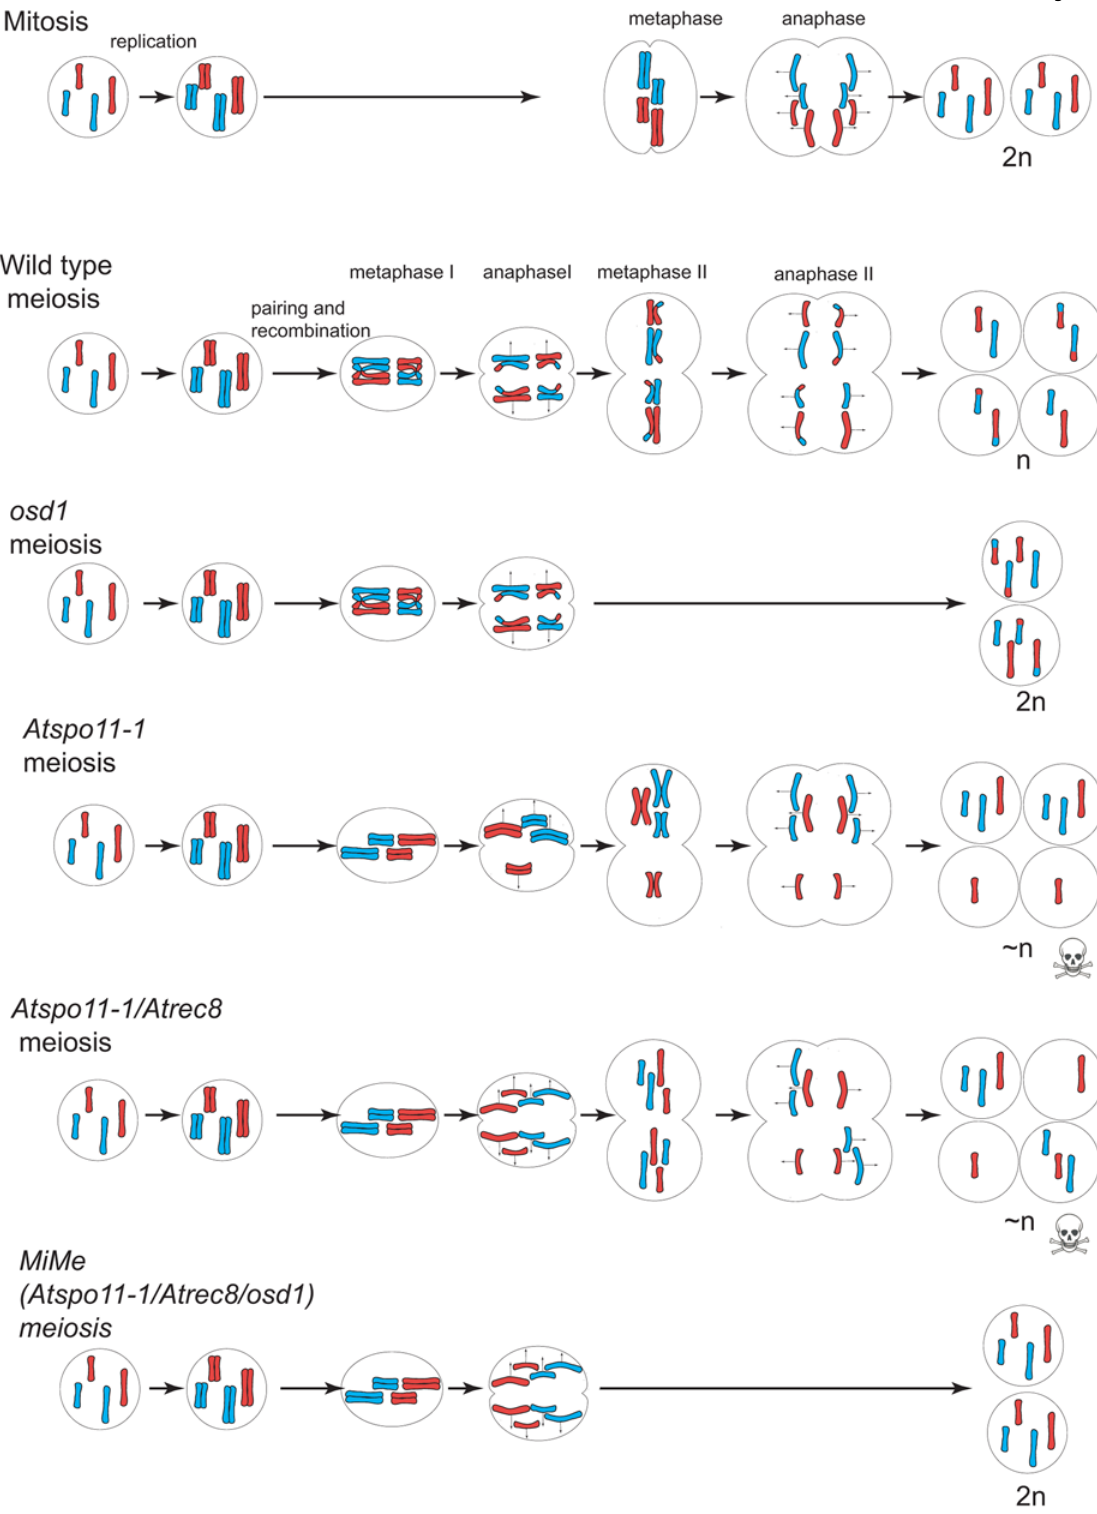
Figure 1. Schematic summary of the main results. During mitosis in diploid cells, chromosomes replicate and sister chromatids segregate to generate daughter cells that are diploid and genetically identical to the initial cell. During meiosis, two rounds of chromosome segregation follow a single round of replication. At division one, homologous chromosomes recombine and are separated. Meiosis II is more similar to mitosis, resulting in equal distribution of sister chromatids. The obtained spores are thus haploid and carry recombined genetic information. In the osd1 mutant (this study), meiosis II is skipped giving rise to diploid spores and gametes with recombined genetic information. The double Atspo11-1/Atrec8 mutant undergoes a mitotic-like division instead of a normal first meiotic division, followed by an unbalanced second division leading to unbalanced spores and sterility [9]. In the triple osd1/Atspo11-1/Atrec8 mutant ( MiMe , this study), the presence of the Atspo11-1 and Atrec8 mutations leads to a mitotic- like first meiotic division, and the presence of the osd1 mutation prevents the second meiotic division from occurring. Thus meiosis is replaced by a mitotic-like division. The obtained spores and gametes are genetically identical to the initial cell. doi:10.1371/journal.pbio.1000124.g001 PLoS Biology | www.plosbiology.org